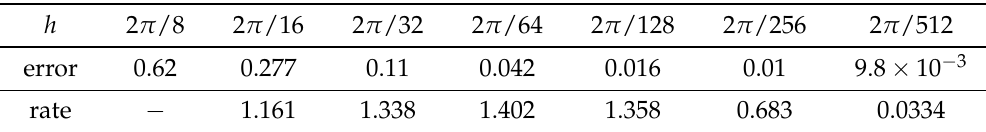
Table 3. Computational error in u h of (21) for α = 0.65 with respect to the L 2 ( Ω ) -norm with the experimental convergence rates.